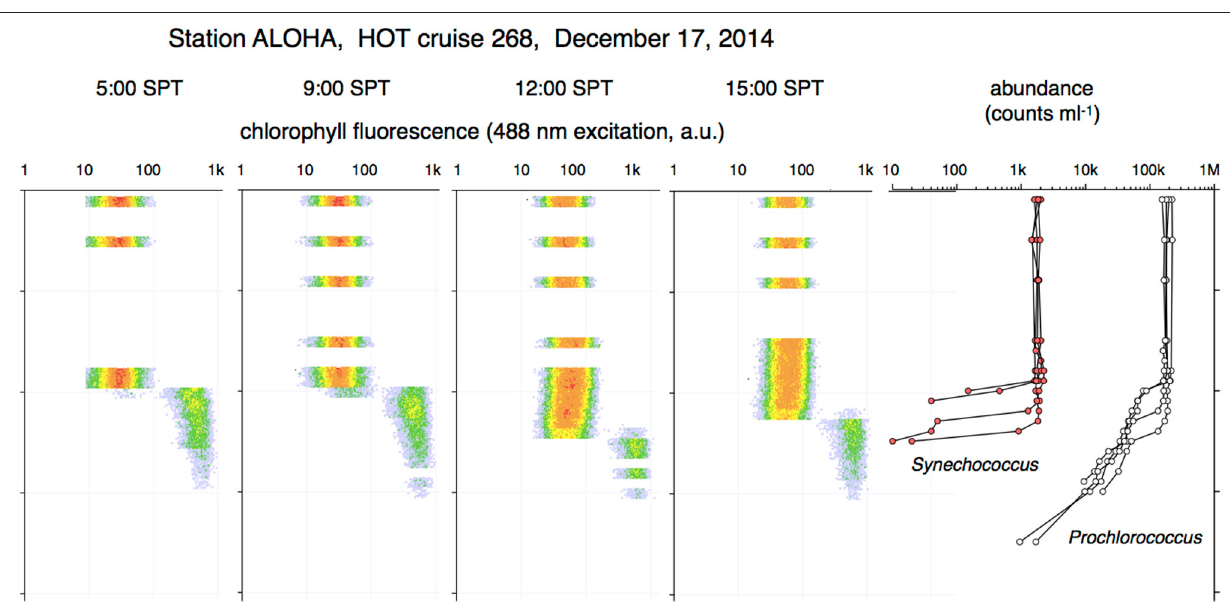
FIGURE 9 | Deep mixing profiles from 4 casts in December 2014. The mixed layer reaches down to 100m. The flow cytometry properties of Prochlorococcus in the upper column are homogeneous. All cells in the pycnocline are of the deep FCM